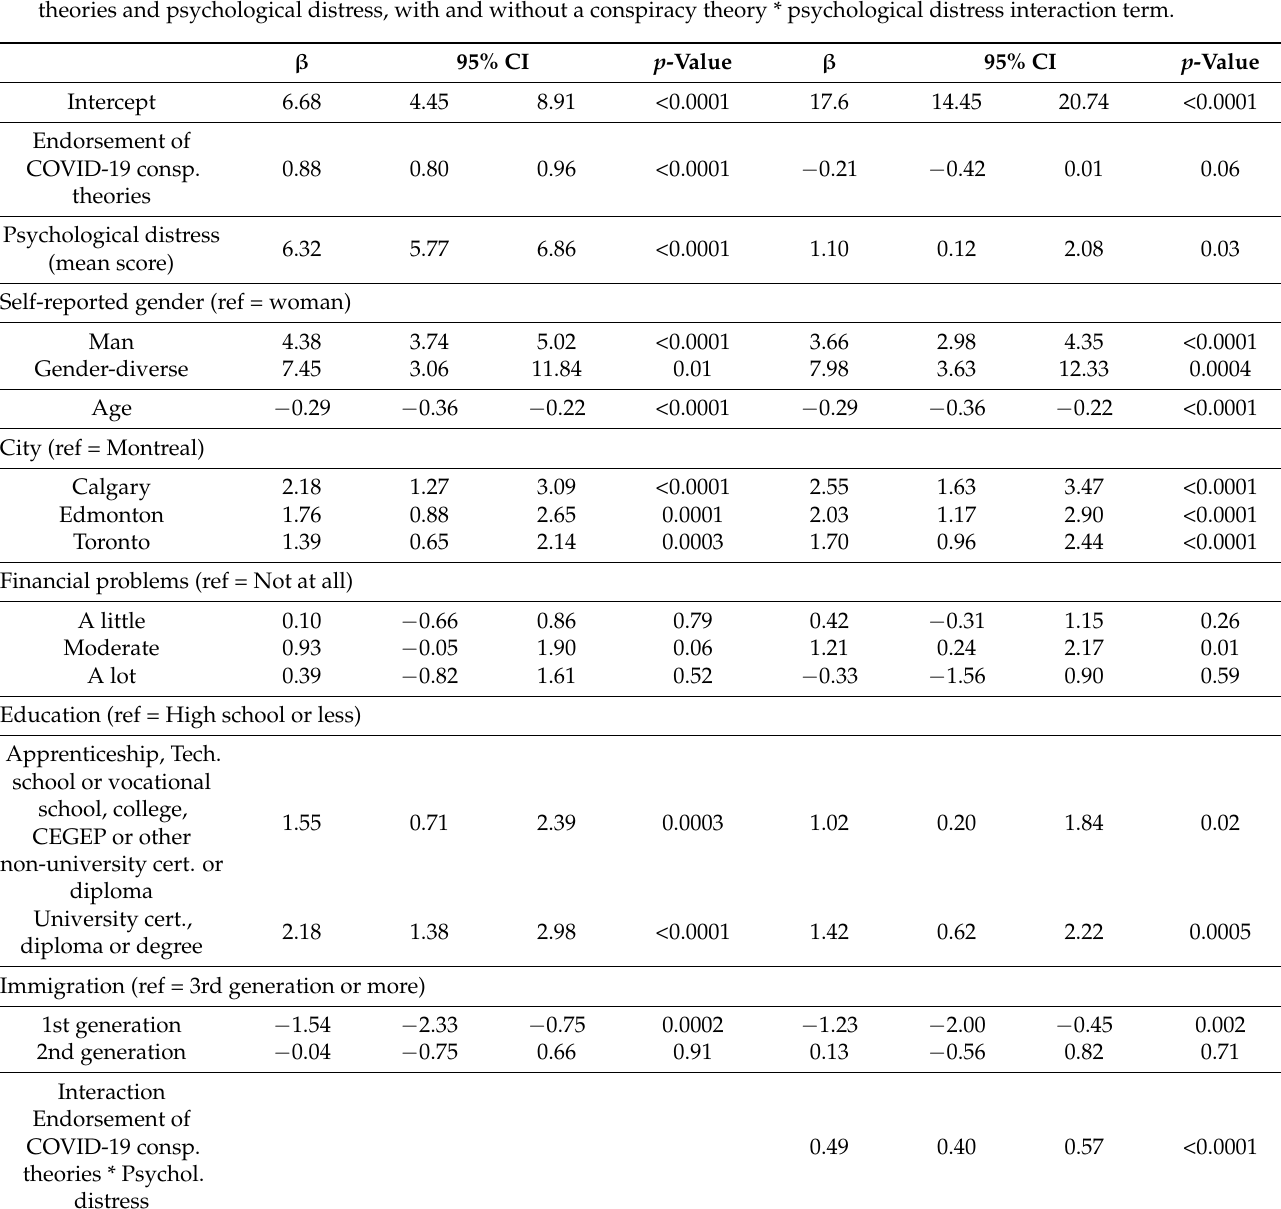
Table 3. Multivariate regressions of support for violent radicalization (SyfoR) on endorsement of COVID-19 conspiracy theories and psychological distress, with and without a conspiracy theory * psychological distress interaction term. β 95% CI p -Value β 95% CI p